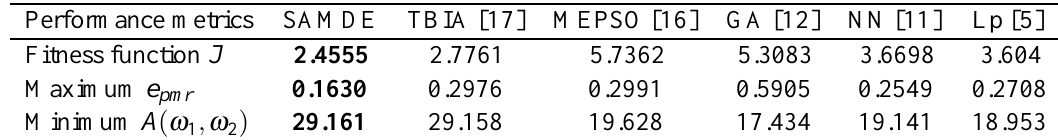
Table 2. Performance comparison of the derived